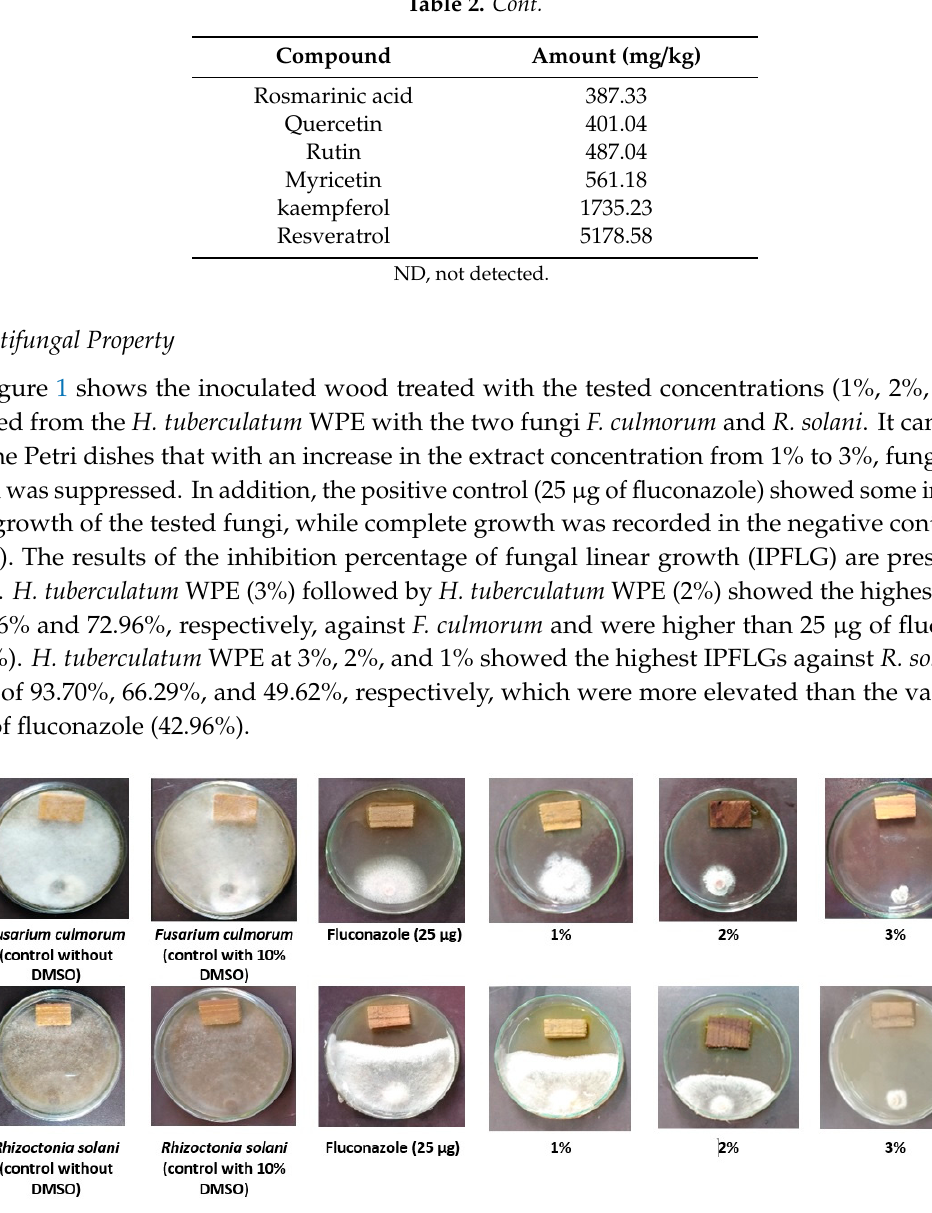
Figure 1. Visual observation of the antifungal property of Haplophyllum tuberculatum whole plant extract (WPE) against Fusarium culmorum and Rhizoctonia solani . Table 3. Antifungal property of wood treated with H. tuberculatum WPE against the growth of F. culmorum , and R. solani .